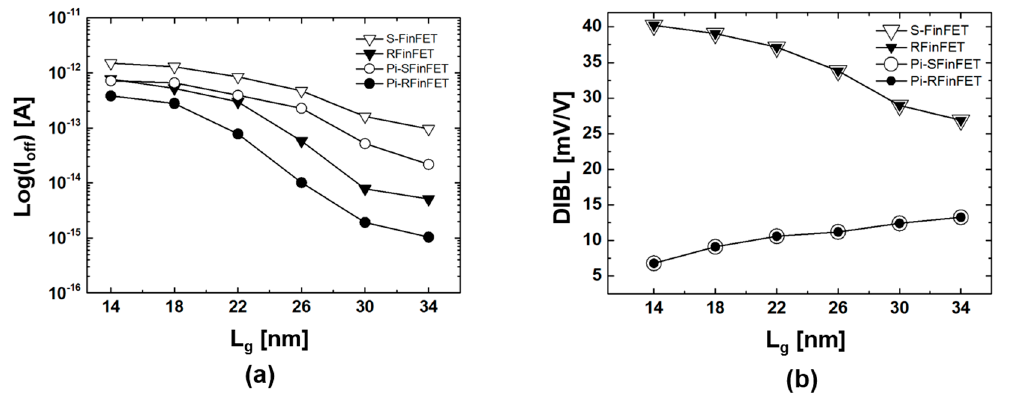
Figure 5. ( a ) I off (V GS = − 0.5 V, V DS = 1.5 V) and ( b ) DIBL (V DS.low = 0.05 V, V DS.high = 1.5 V) dependence on L g of conventional S-FinFETs and Pi-FinFETs.